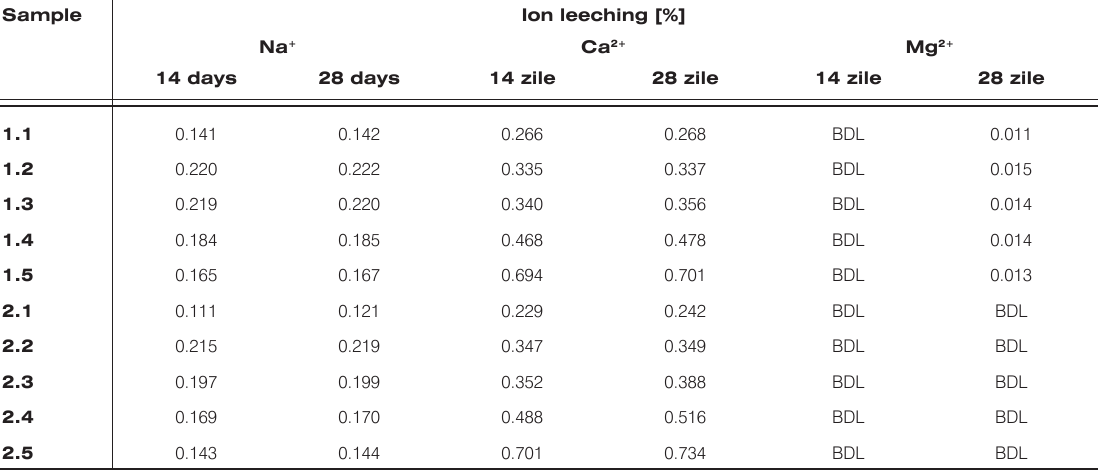
Table 4. The ions leeching from the investigated glass foams. Sample